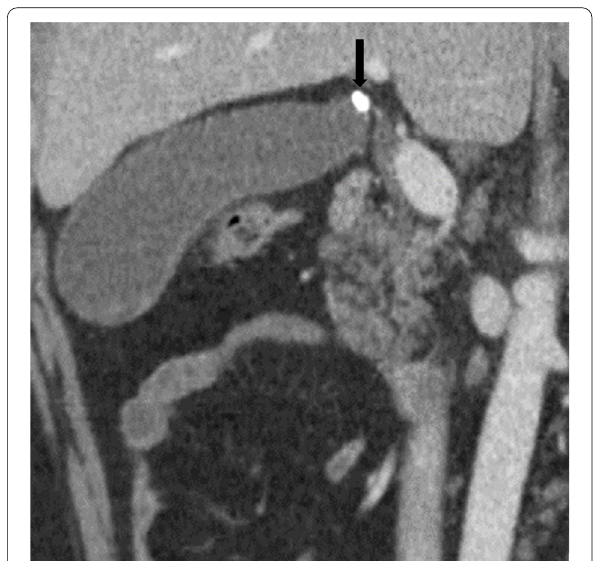
Fig. 1 Computed tomography. Arrow indicates incarceration of a small in the neck of the gallbladder